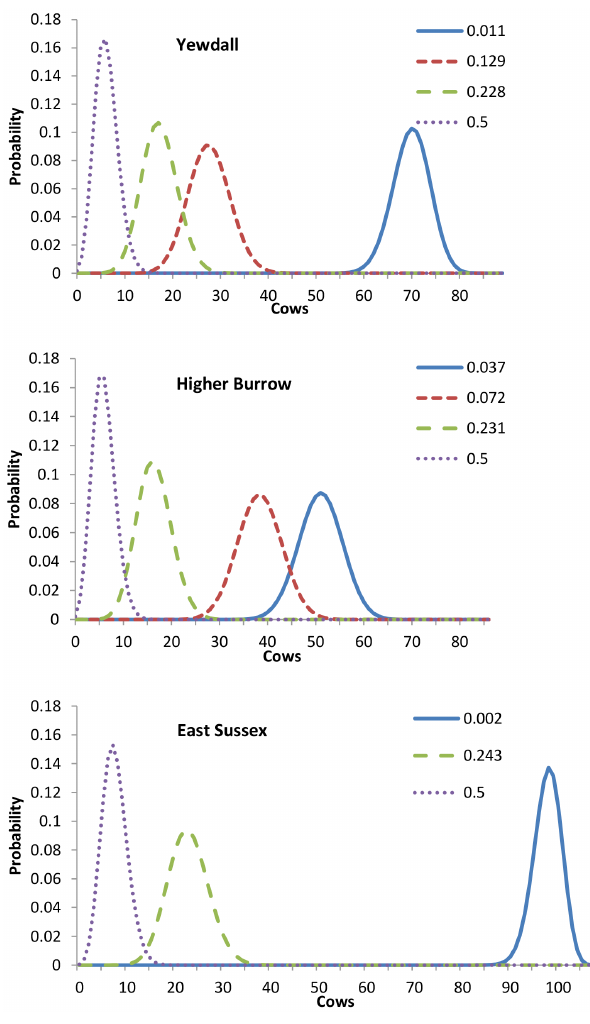
Figure 9. The number non-infected cows predicted to have tested c IFN positive in three herds. The mean binomial probability densities are shown for farms ‘Yewdall’, ‘Higher Burrow’ and ‘East Sussex’. Different coloured lines represent various calculated prevalence estimates, the values of which are given.